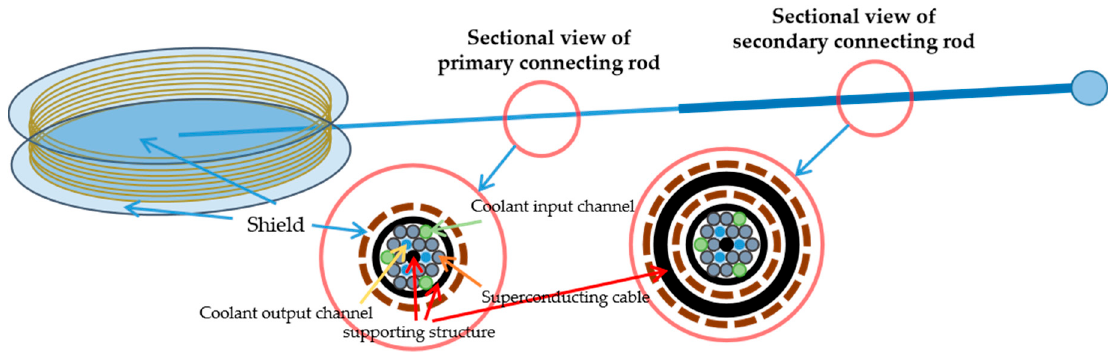
Figure 4. Diagram of the shielding structure.